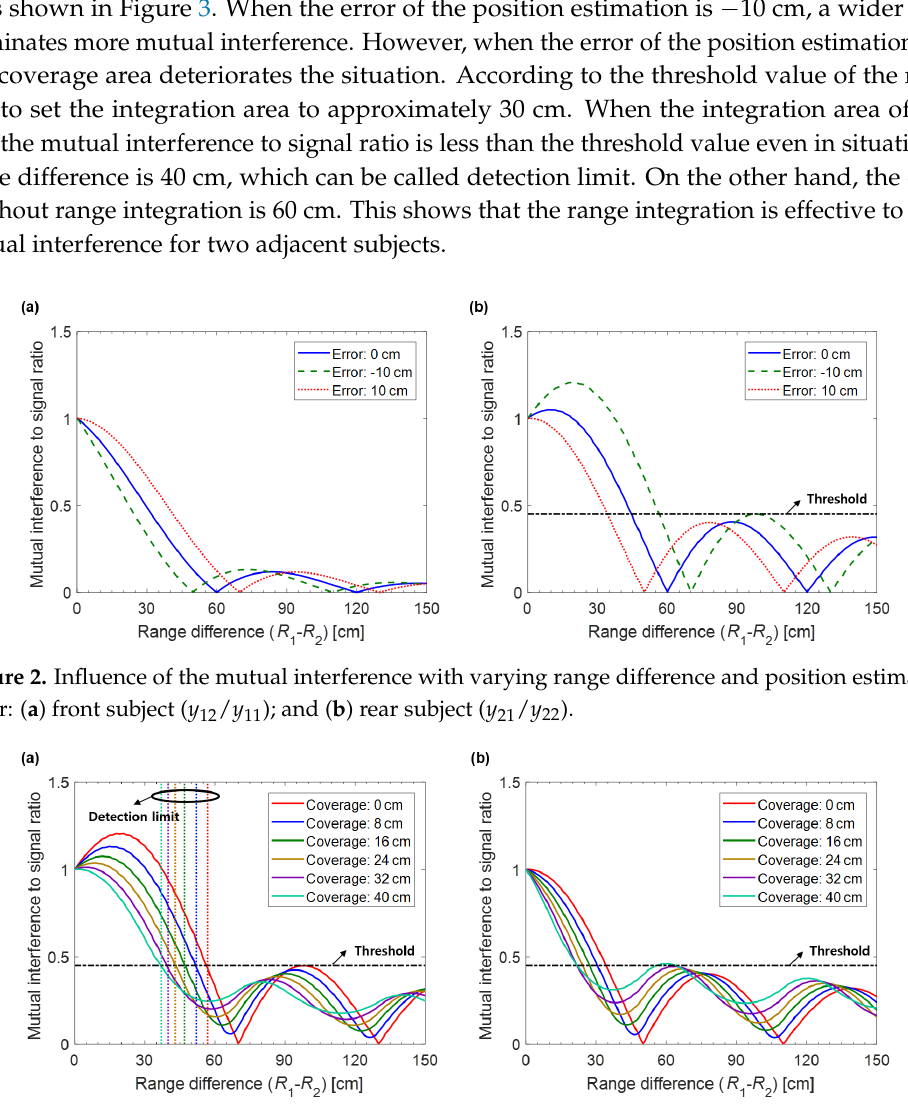
Figure 3. Effect of the range integration for the rear subject ( y 21 / y 22 ): ( a ) position estimation error: − 10 cm; and ( b ) position estimation error: 10